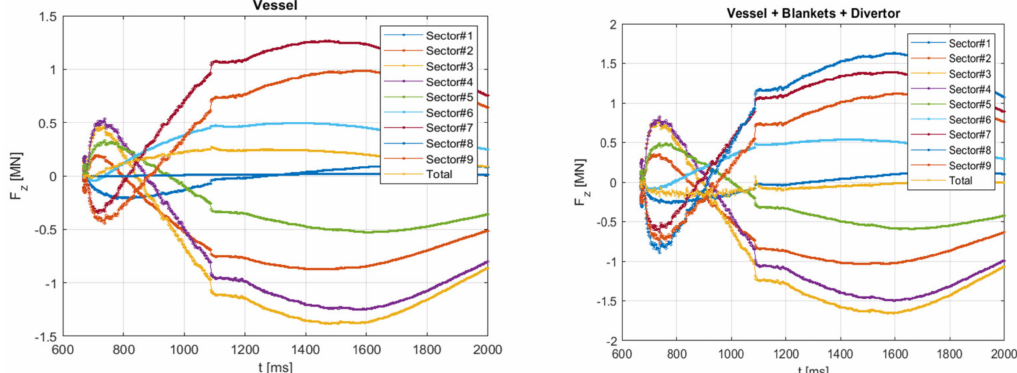
Figure 7. Model #2 has 101 thin identical helical bridges wrapping around the plasma: yellow dots show traces of these bridges in the poloidal plane, red circles mark “halo current injection belts”.